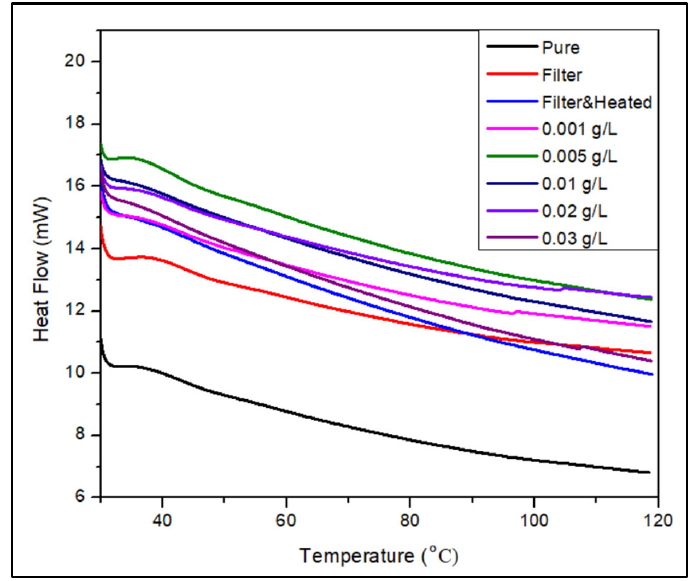
Figure 11. Heat flow of different types of samples.